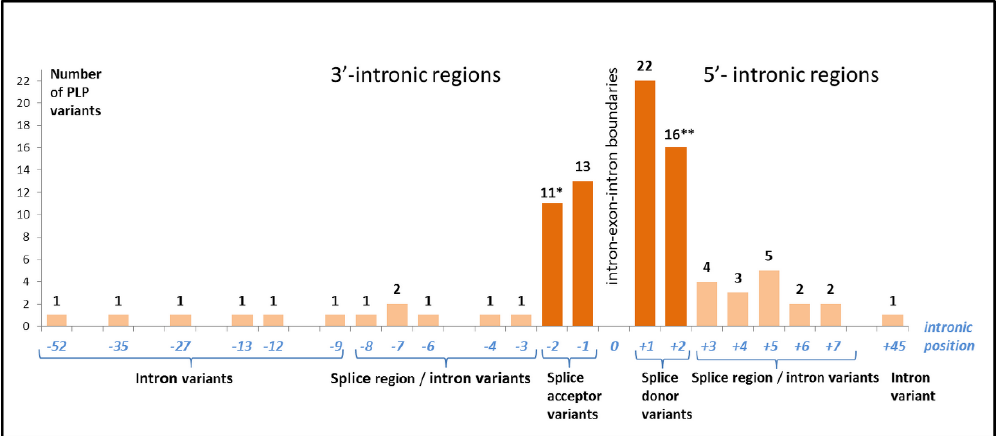
Figure 4. Distribution of PLP variants located in the SLC26A4 intronic regions. *—variant c.1342- 2_1343dup (splice region variant /intron variant) was included; **—variant c.164+2_164+5delinsGAGG (“splice donor variant/intron variant”) was